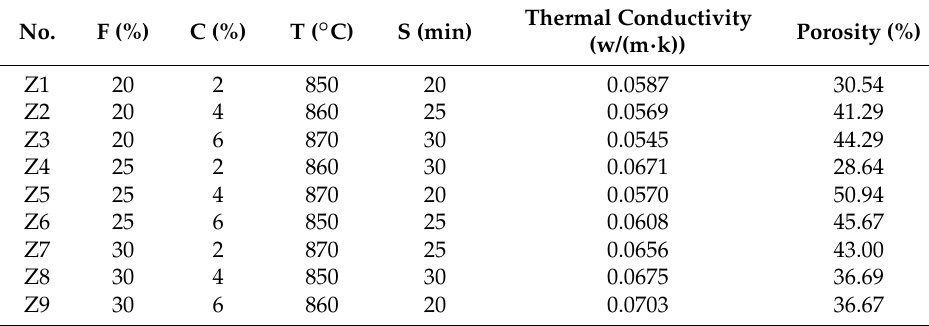
Table 3. The L 9 (3 4 ) Orthogonal experiment results.